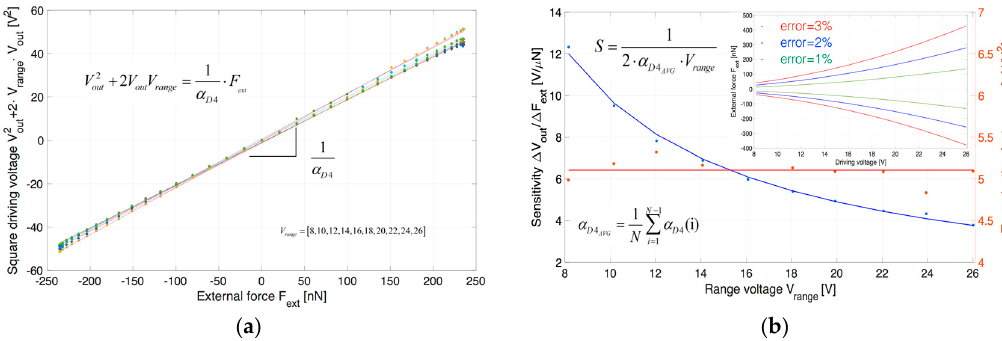
Figure 4. ( a ) The estimation of the electro-mechanical transduction factor (cid:2009) (cid:2888)(cid:2872) ; ( b ) Sensitivity S and electro-mechanical transduction factor (cid:2009) (cid:2888)(cid:2872) as function of (cid:1848) (cid:2928)(cid:2911)(cid:2924)(cid:2917)(cid:2915) . Red line represents the average value of (cid:2009) (cid:3005)(cid:2872) while blue line is the calculated sensitivity. The inset of Figure 4b shows the range of measurable external forces with non-linearity error of 1%, 2% and 3% of the